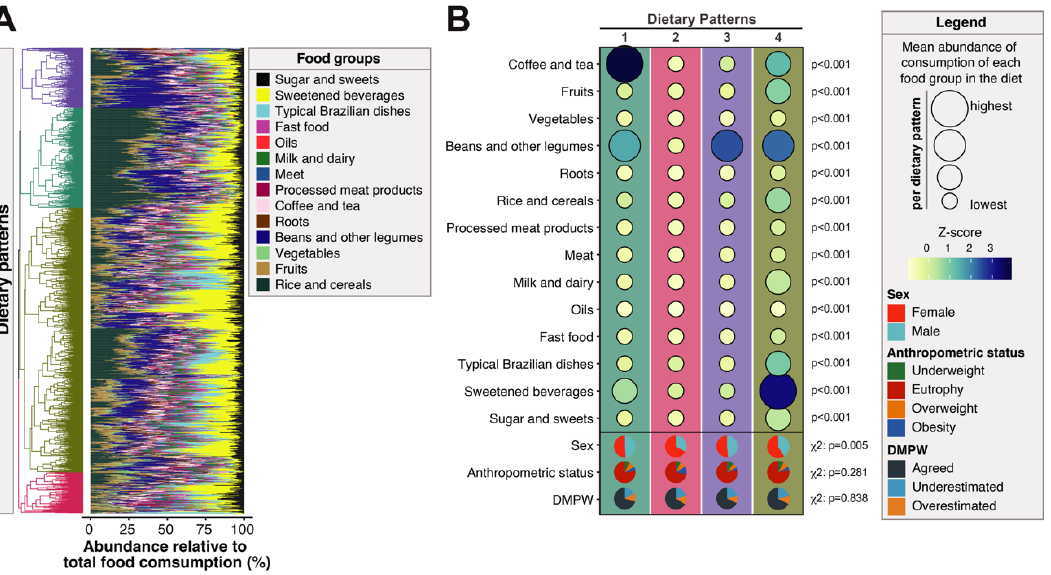
Figure 2. Profiles of consumption of food groups using hierarchical clustering. The abundance of consumption of the indicated food groups in the diet was calculated for each individual as described in Methods. ( A ) Hierarchical cluster analysis (Ward’s unsupervised method), in which the dendrograms represent the Euclidean distance, was used as an approach to identify di ff erent dietary patterns. Using this approach, it was possible to identify four major consumption patterns. ( B ) Upper panel shows the average relative abundance consumption of each food group within each dietary pattern identified in the hierarchical cluster analysis. Lower panel shows frequencies individuals in each dietary pattern stratified by sex, anthropometric status and also by divergence between measured and perceived weight (DMPW). The average relative abundance of consumption of each food group was compared between the di ff erent dietary patterns using one-way ANOVA. Proportions of sex, anthropometric status, and divergence between measured and perceived weight were compared between the di ff erent dietary profiles using the Pearson’s chi-square test. All p -values are indicated. Table 3. Abundance of consumption of each food group in the diet in different dietary patterns Dietary Patterns Food or Food Group